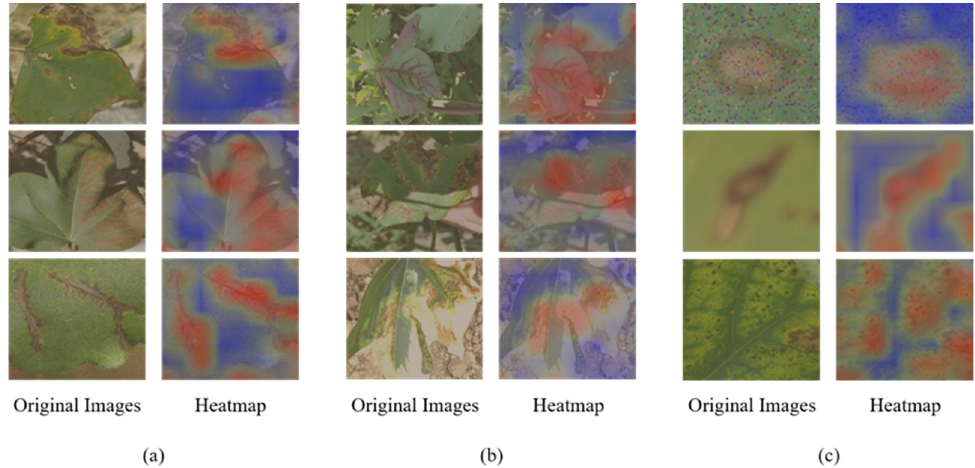
Figure 7. Visualization results of feature images of test sets, where ( a ) represents heatmaps for different leaf diseases, ( b ) represents heatmaps for different backgrounds and lighting, and ( c ) represents heatmaps with different noise interference.